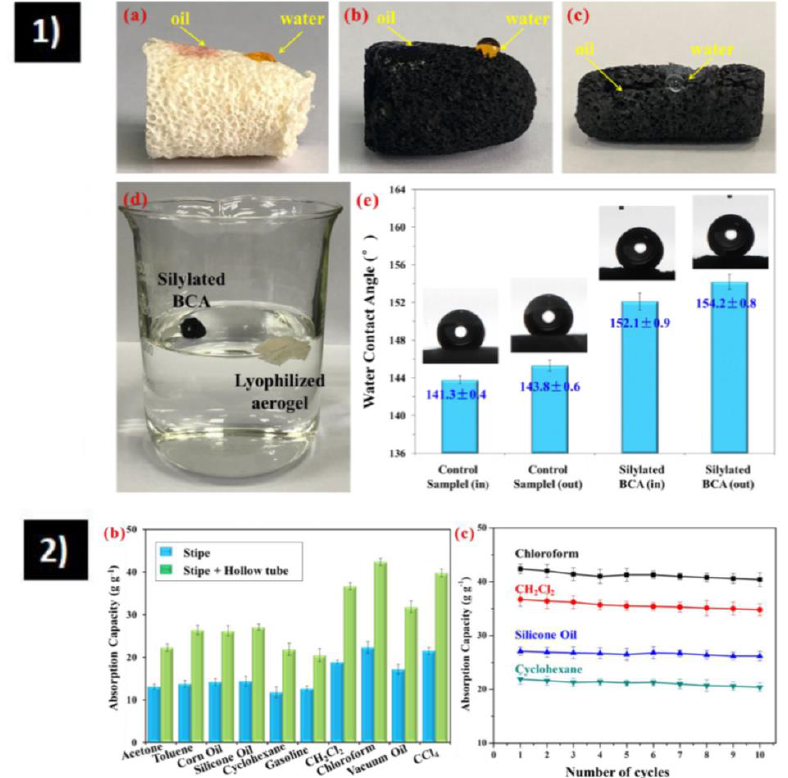
Figure 3. ( 1 ) Wettability of the bamboo fungus-based aerogel. (a) Images illustrating that water and oil droplets are placed on the surface of lyophilized aerogel (above), (b) silylated biomass-based carbon aerogel (BCA), and (c) freshly cut surface of silylated BCA. (d) Image depicting different water repellencies of silylated BCA and lyophilized aerogel. (e) Water contact angle on silylated BCA and control sample, wherein the in represents the inner surface and the out indicates the outer surface. ( 2 ) Oil absorption performance of the bamboo fungus-based aerogel. (b) Mass-based absorption capacities of the silylated BCA for various oils and solvents. (c) Cyclic absorption performance for the silylated BCA [91] .